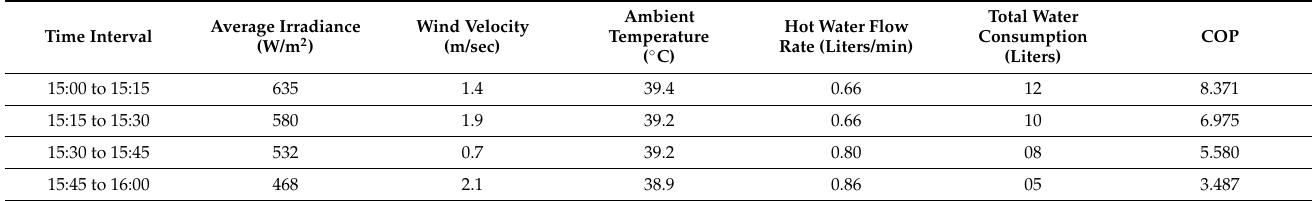
Table 5. Total water consumption—35 L (Electricity consumption—0.3 kWh).